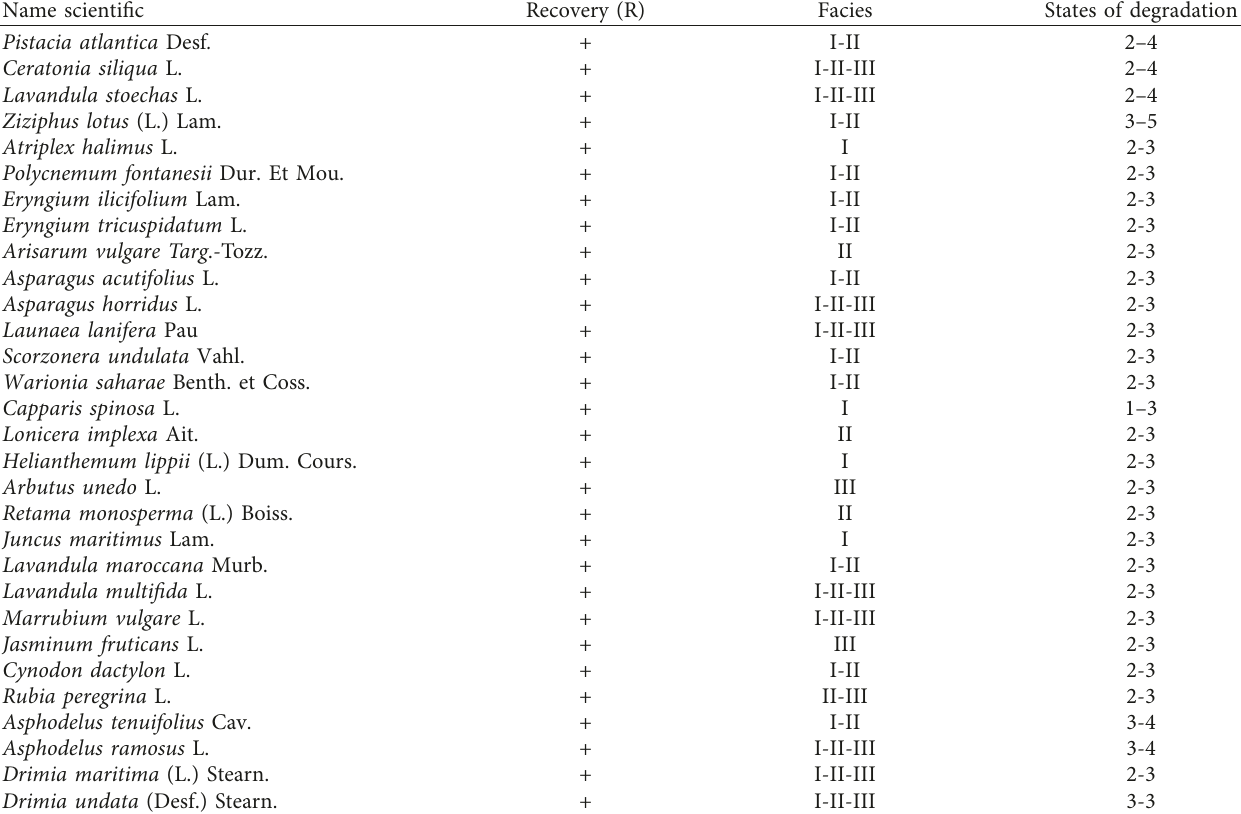
Table 3: List of potentially non-exploitable AMPs within the Bigoudine watershed production potentials in green matter of some medicinal species. Name scientific